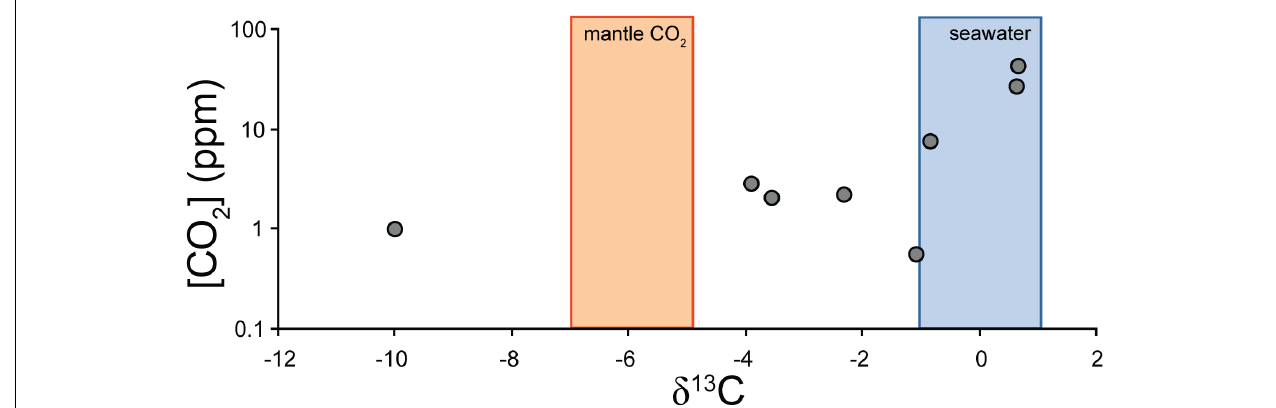
FIGURE 9 | Carbonate stable carbon isotope and CO 2 yield data for SFVC separates, with ranges for the mantle and seawater marked by colored bars. All but one of the data fall between mantle and seawater, consistent with carbonate derived largely from these sources. The anomalous sample, G9, contains additional light carbon of uncertain